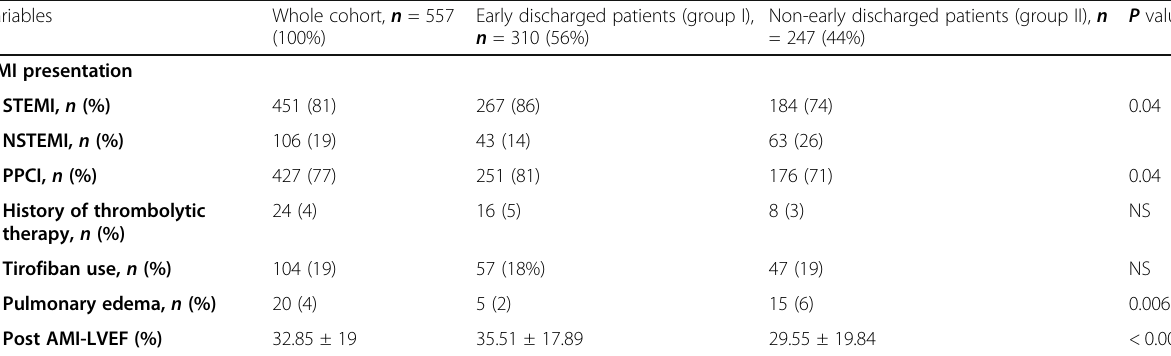
Table 2 Clinical data in the whole cohort and comparison of early discharge group versus non-early discharge group